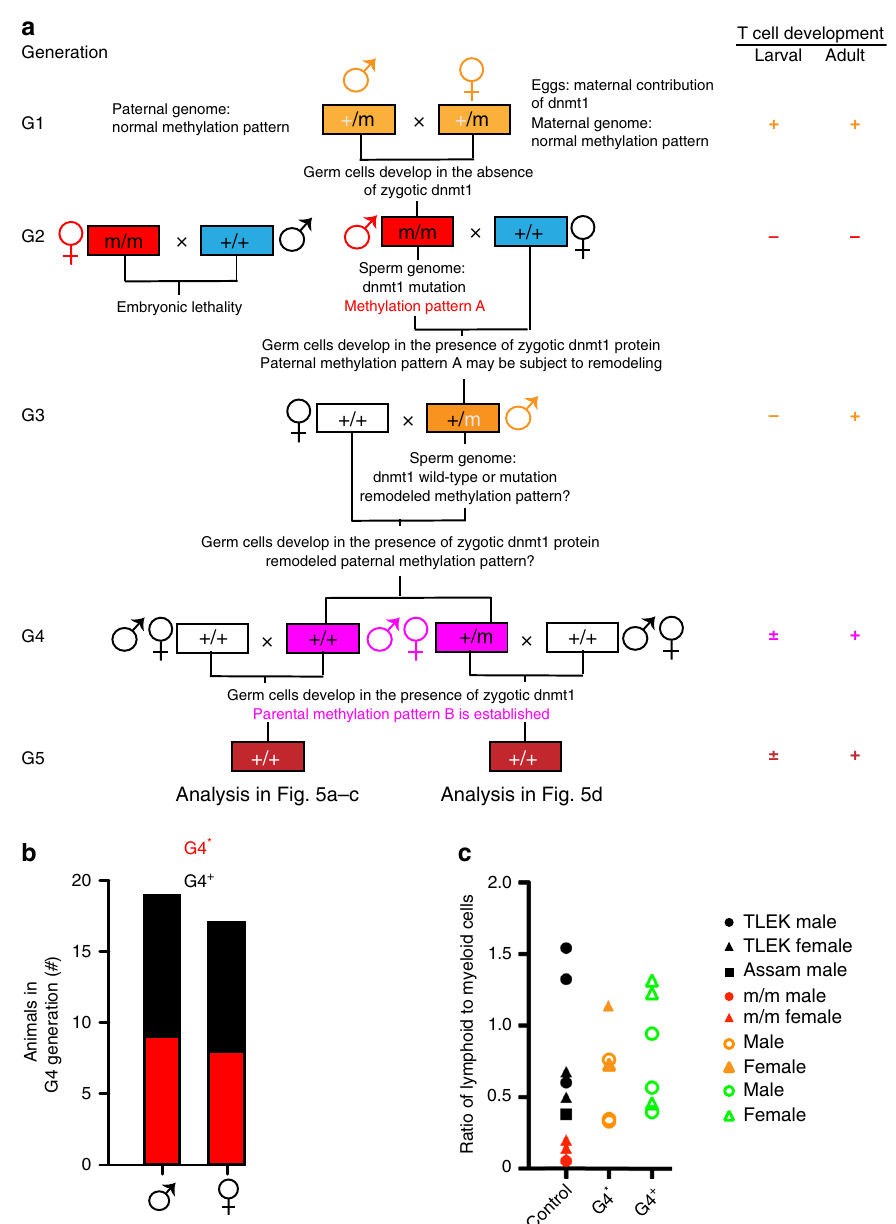
Fig. 4 Transgenerational inheritance of failing larval T cell development. a Structure of pedigree; the genotypes and sex of animals is indicated. White boxes, wild-type animals unrelated to the dnmt1 -mutant lineage; blue boxes, genotypically wild-type animals arising from various crosses in the dnmt1 - mutant lineage. The presence ( + ) or absence ( − ) of larval and adult phases of T cell development in different generations of the pedigree are indicated on the right, with colors matching the relevant genotypes. The ± sign indicates that larval T cell development is impaired in some but not all G4 and G5 animals. b Genotypically wild-type ( dnmt1 + / + ) males and females of the G4 generation give rise to off-spring with (G4*) or without (G4 + ) impaired larval T cell development when crossed to wild-type animals. c Normal adult hematopoiesis in fi sh of different genetic backgrounds. Whole kidney marrow cells were analyzed by fl ow cytometry (see Fig. 2c, left panel) and cell numbers in the lymphoid and myeloid gates were counted 47 . The genotype of animals is indicated to the right; TLEK and Assam represent wild-type strains. Note the normal lymphoid/myeloid ratios in adult G4* animals. Each data point represents one animal. Source data are provided as Source Data fi were originally indistinguishable in G2 exhibit lower methylation and G4 * sperm DNAs are non-randomly distributed across the levels in G4 * (Fig. 6b; Supplementary Data 3). Of the 79 genome (Fig. 6c), with chromosomes 6, 9, 10, and 16 being hypermethylated DMRs distinguishing G4 + and G4 * sperm particularly affected (Fig. 6d). DNAs, the status of 75 DMRs could be assessed in G2; 58 of these DMRs exhibited similar methylation levels in wild-type and mutant G2 sperm, whereas 17 DMRs were found to have lower methylation levels in G2 m/m sperm as compared to wildtype (Fig. 6b; Supplementary Data 3). The DMRs distinguishing G4 +